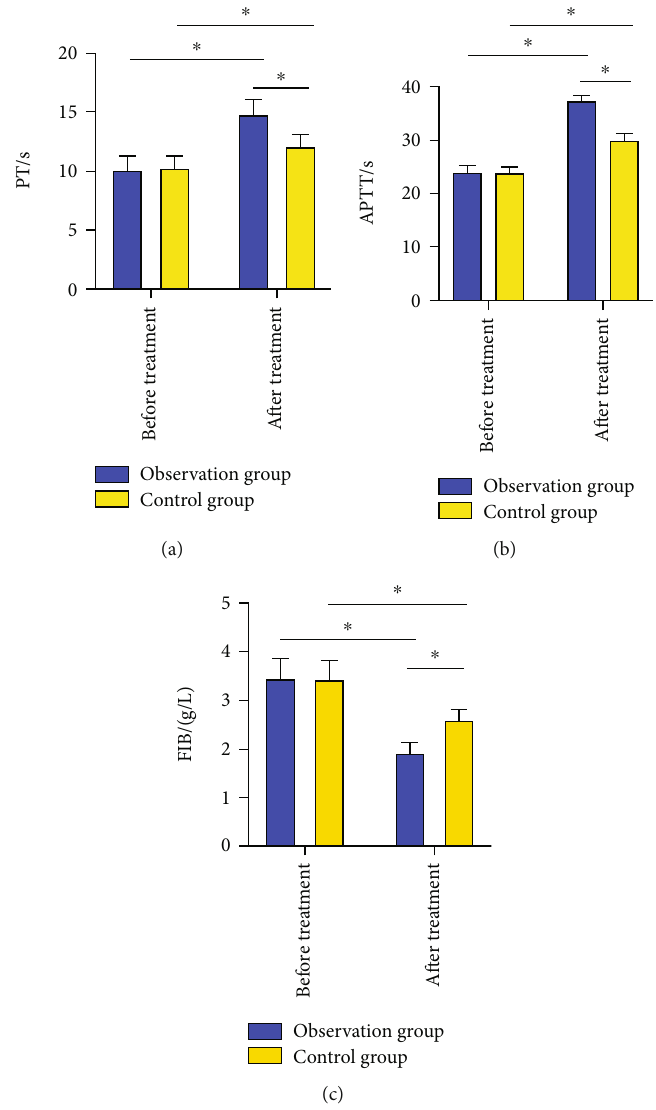
Figure 2: Comparison of blood coagulation function before and after treatment between two groups of patients: (a) comparison of PT between two groups of patients; (b) comparison of APTT between two groups of patients; (c) comparison of FIB between two groups of patients. ∗ P < 0 : 05 . Table 5: Comparison of the prognosis between the two groups of